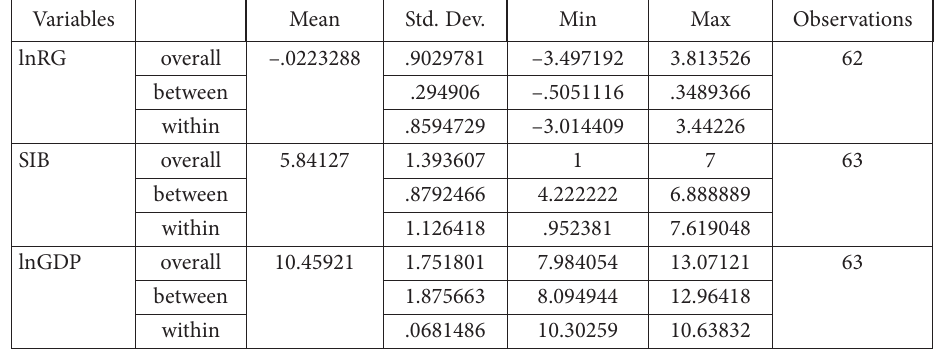
Table 4. Description Statistics for variables (source: author’s calculation, 2021)